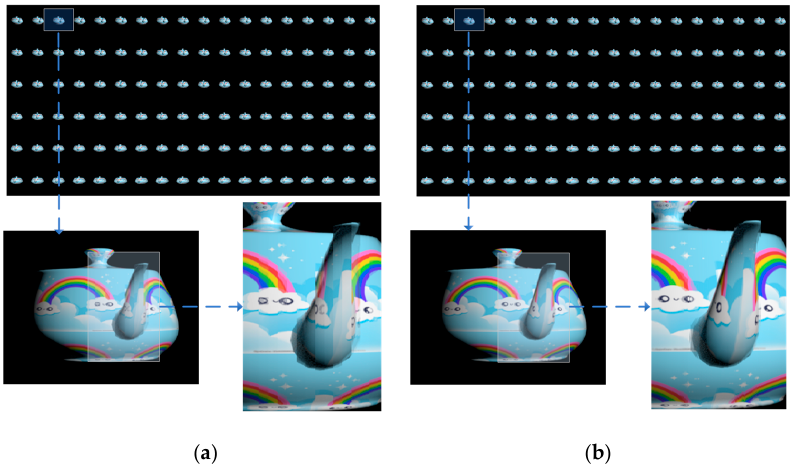
Figure 8. Overall and local enlargement of the projector image array. The PIA generated by the SPOC algorithm ( a ) and target pixel matching algorithm ( b )